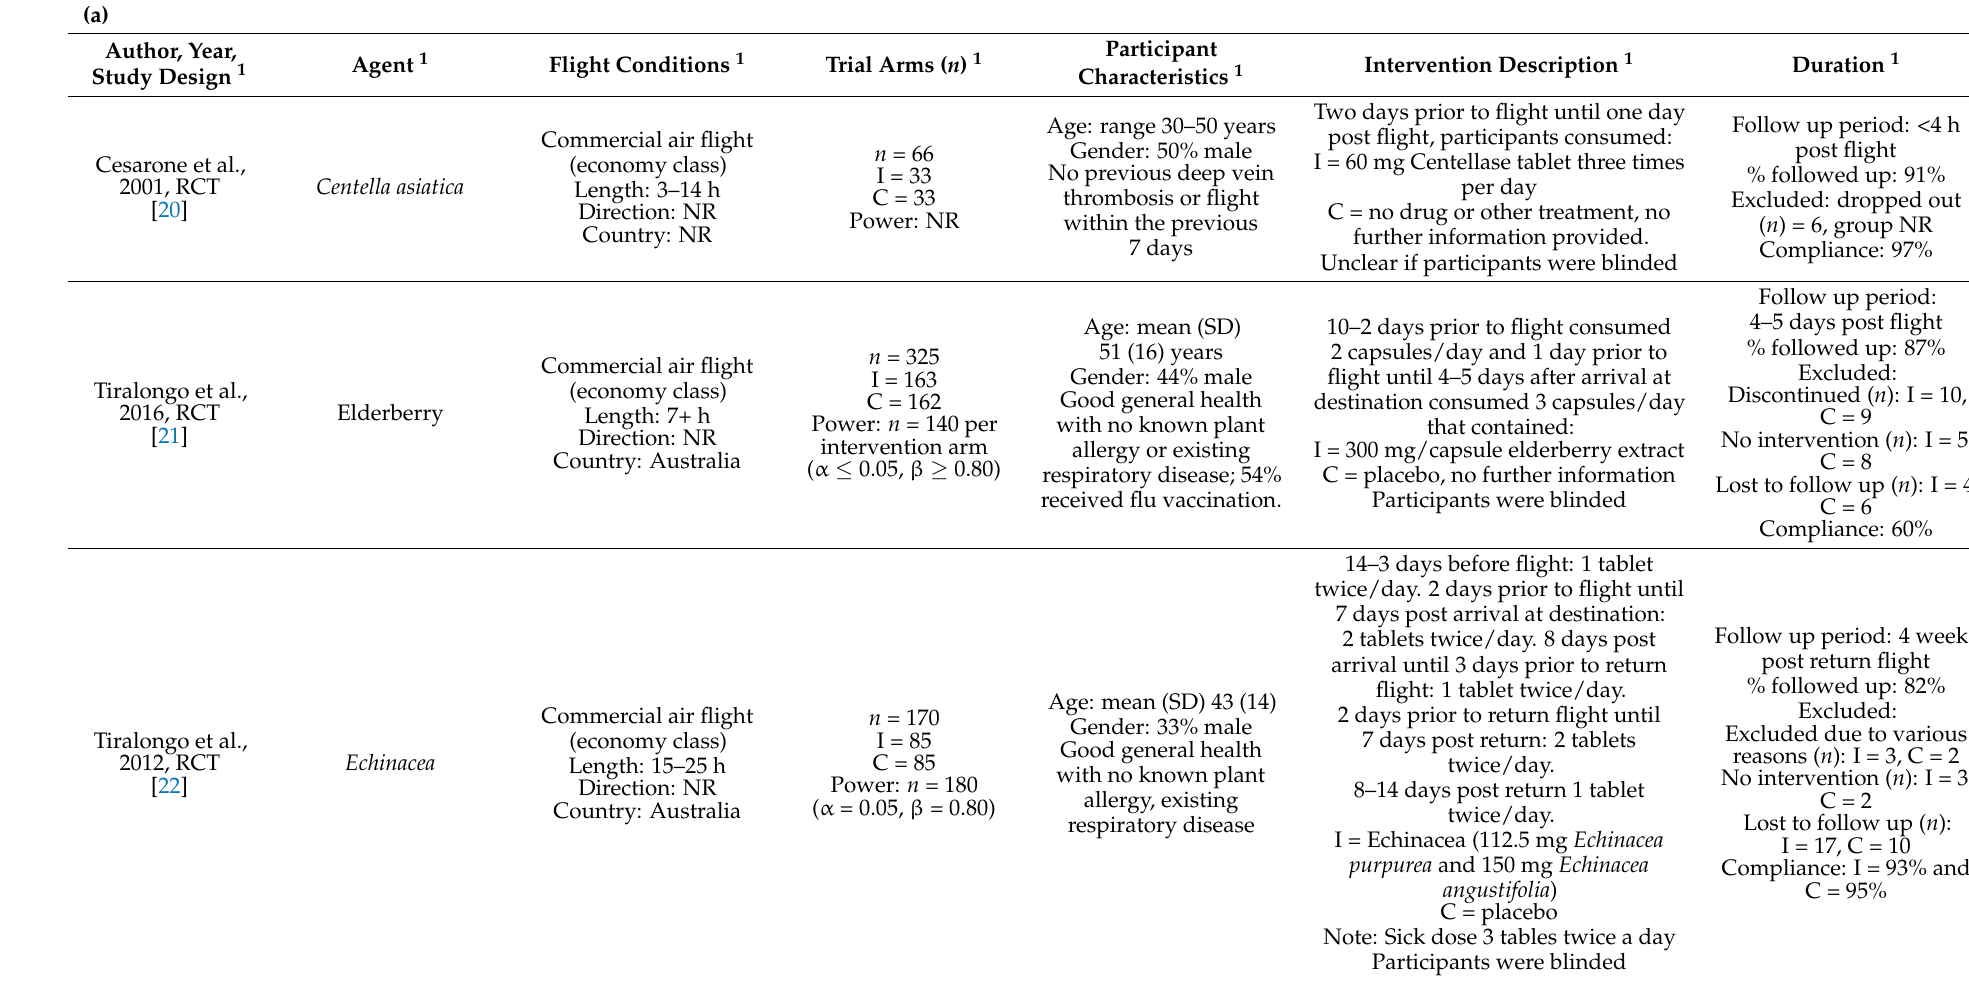
Table 3. Summary of included studies and demographics of participating populations conducted within ( a ) flight settings and ( b ) simulated flight